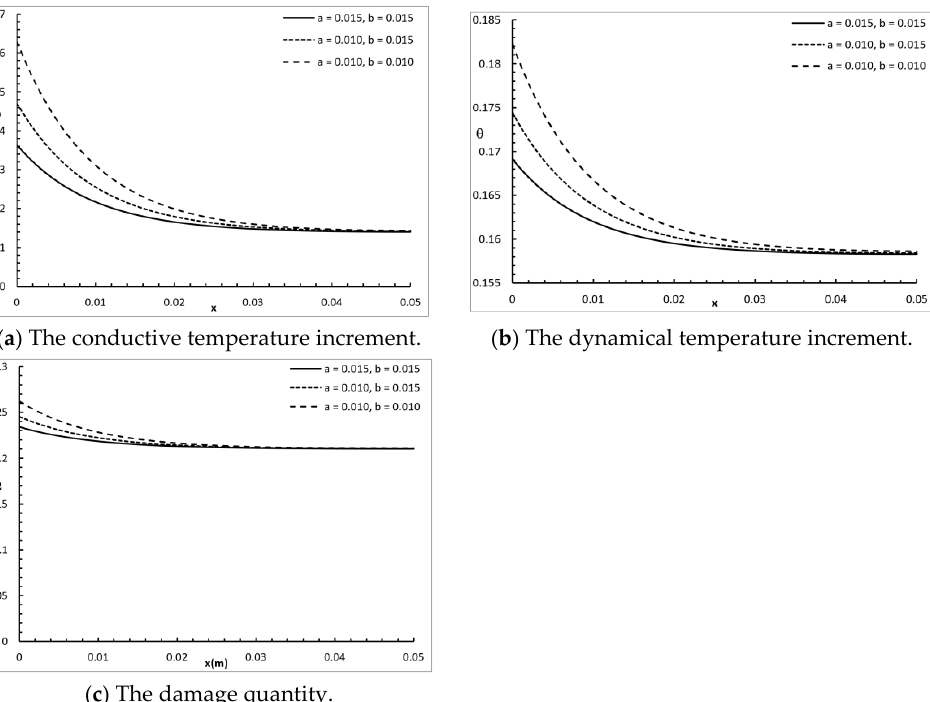
Figure 5. The studied functions for various values of the rectangular laser pulse.